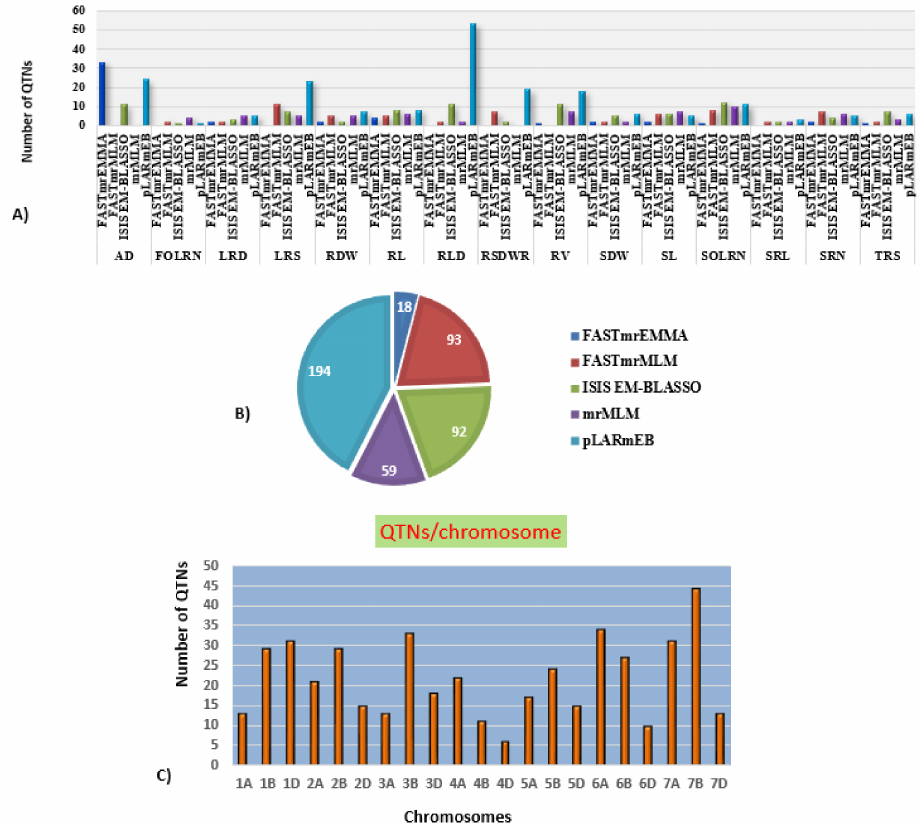
Figure 3. Distribution of the QTNs (quantitative trait nucleotides) identified using five different multi- locus GWAS (genome wide association study) models. ( A ) Number of significant QTNs detected for 15 traits across five multi-locus GWAS methods. ( B ) Number of significant QTNs detected using each of five multi-locus GWAS methods. ( C ) Number of QTNs per